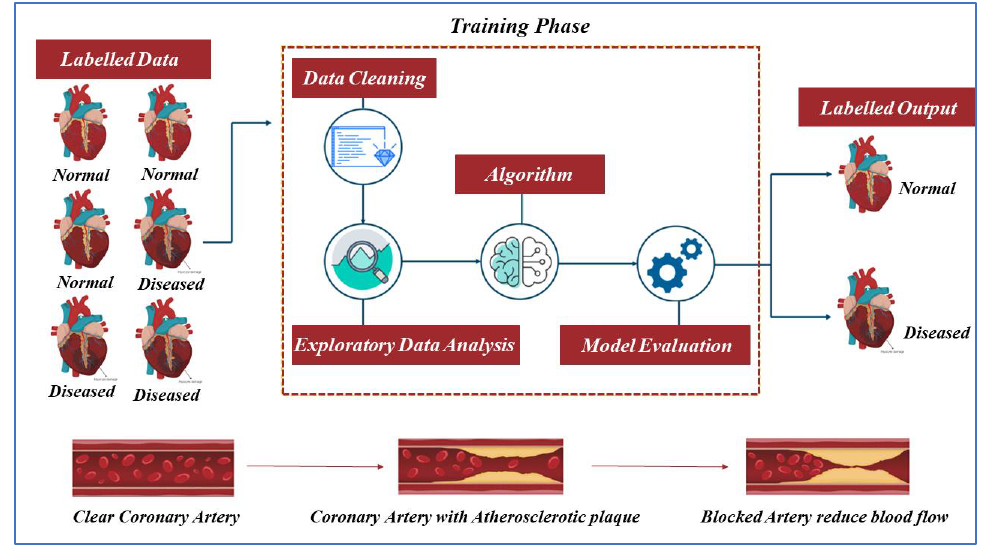
Figure 1. System Working Methodology.